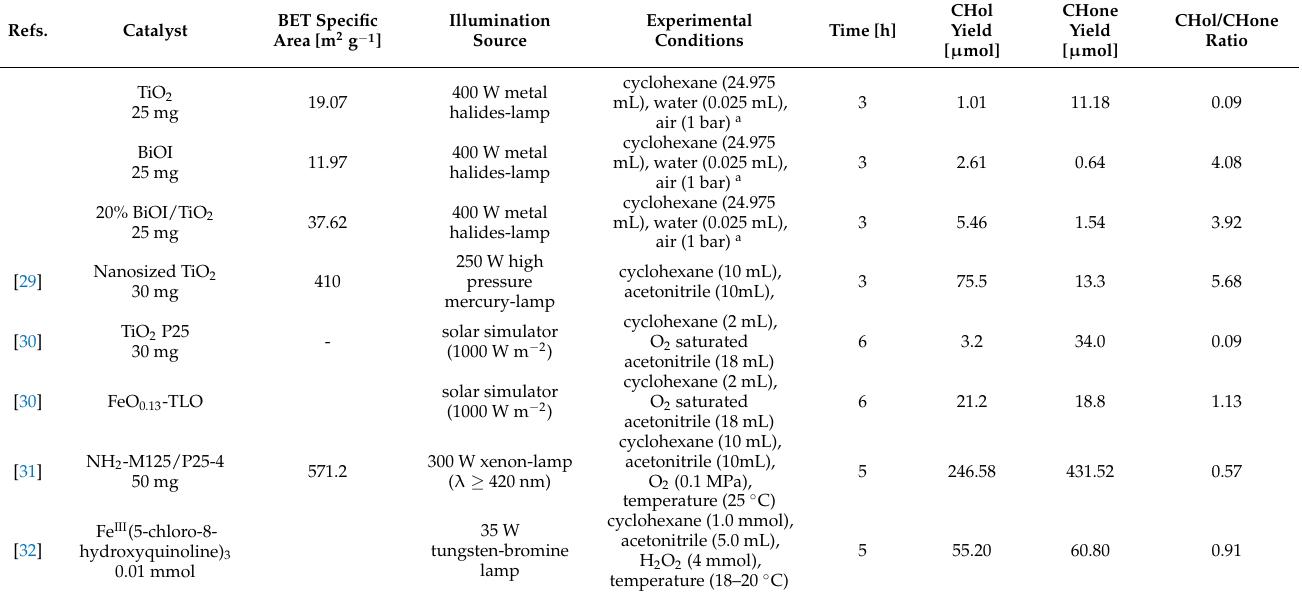
Table 2. Selective photocatalytic oxidation of cyclohexane over synthesized photocatalysts and others reported